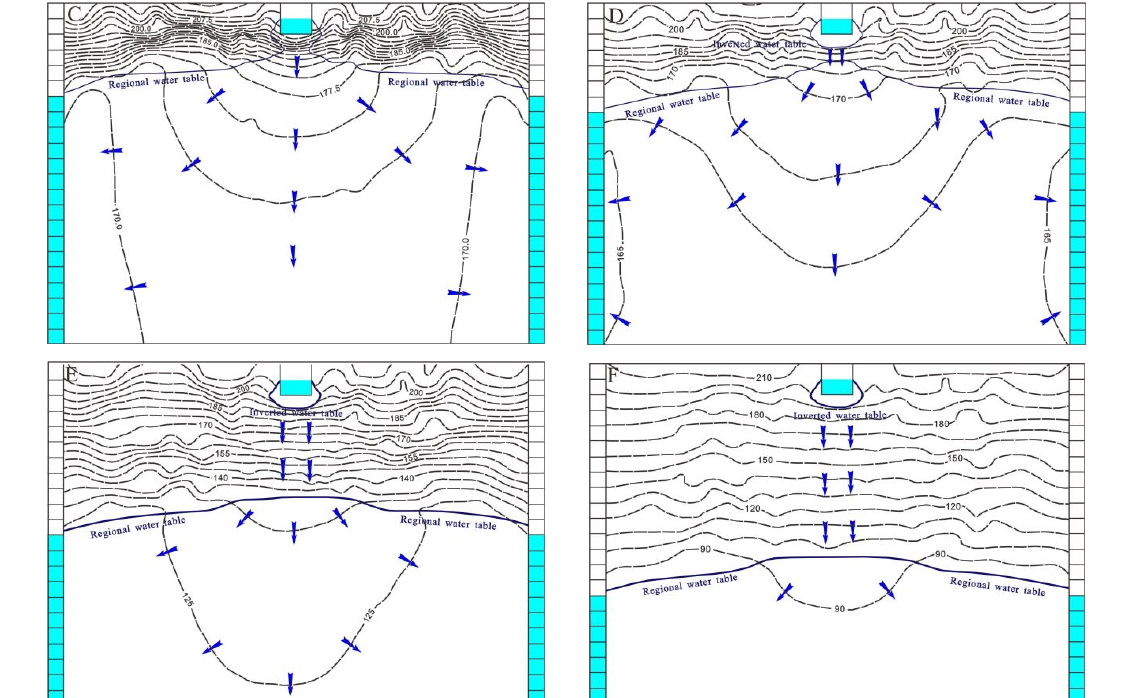
Figure 4. The change in the relationship between river water and groundwater in the sandbox ex- periment under the water-bearing medium sand C and a river water depth of 10 cm. Discharge water level ( A ): 200 cm, ( B ): 170 cm, ( C ): 160 cm, ( D ): 150 cm, ( E ): 110 cm, and ( F ): 70 cm.